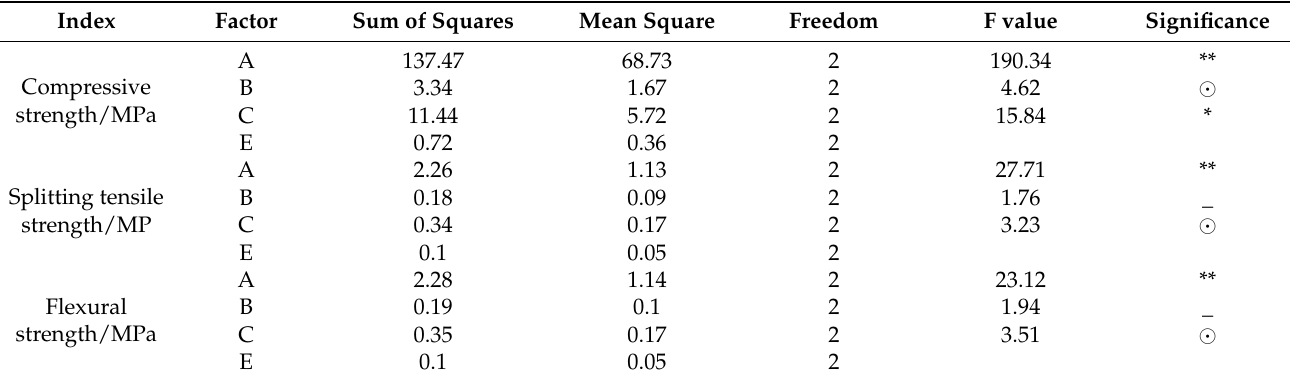
Table 6. Calculation result of variance of HFRC strength.